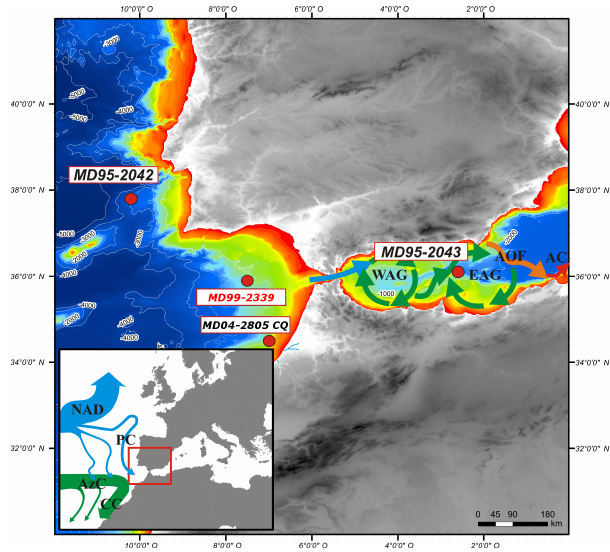
Figure 1. Area of interest with major sea-surface features. Study core MD99-2339, as well as other cores discussed in the paper, is located on the large map, which also depicts the bathymetry of the study area and the major surface currents within the Alboran Sea. WAG: Western Alboran Gyre; EAG: Eastern Alboran Gyre; AOF: Almeria–Oran Front; AC: Algerian Current. The small map on the left presents large-scale North Atlantic currents, with the North At- lantic Drift (NAD), the Portugal Current (PC) flowing southward from 45 to 30 ◦ N, the Azores Current (AzC) derived from the south- ern branch of the Gulf Stream and flowing eastward to the Gulf of Cadiz at about 35 ◦ N, and the Canary Current (CC) fed by both the AzC and the PC. Together, these currents form the Eastern Bound- ary Current of the North Atlantic subtropical